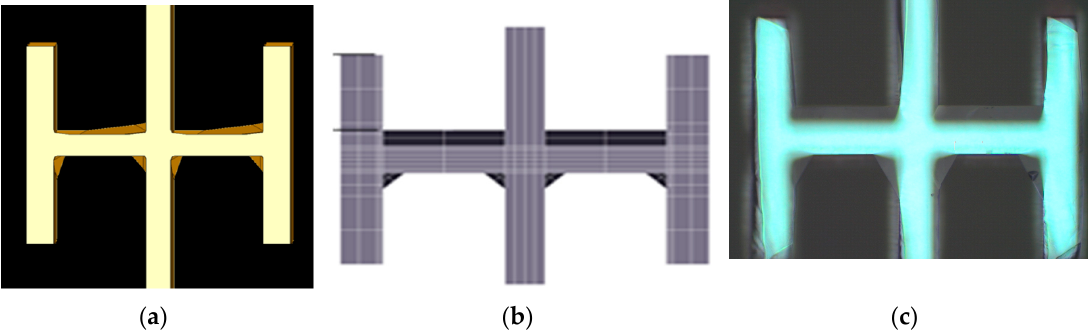
Figure 2. Predicted etching facets ( a ), finite element model taking into account etching facets ( b ), actual etching facets on the quartz cell ( c